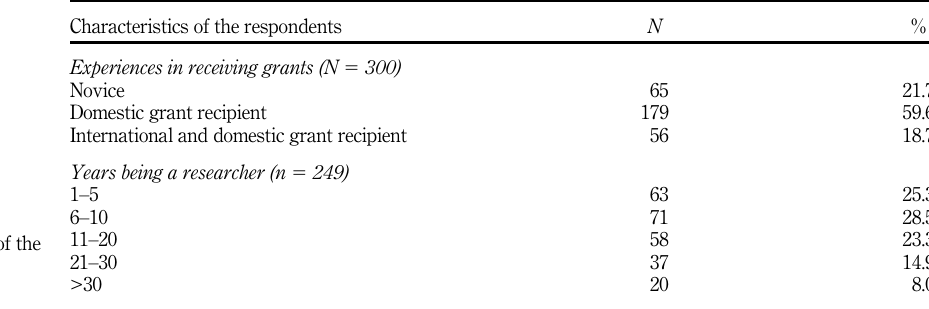
Table 1. Characteristics of the online survey